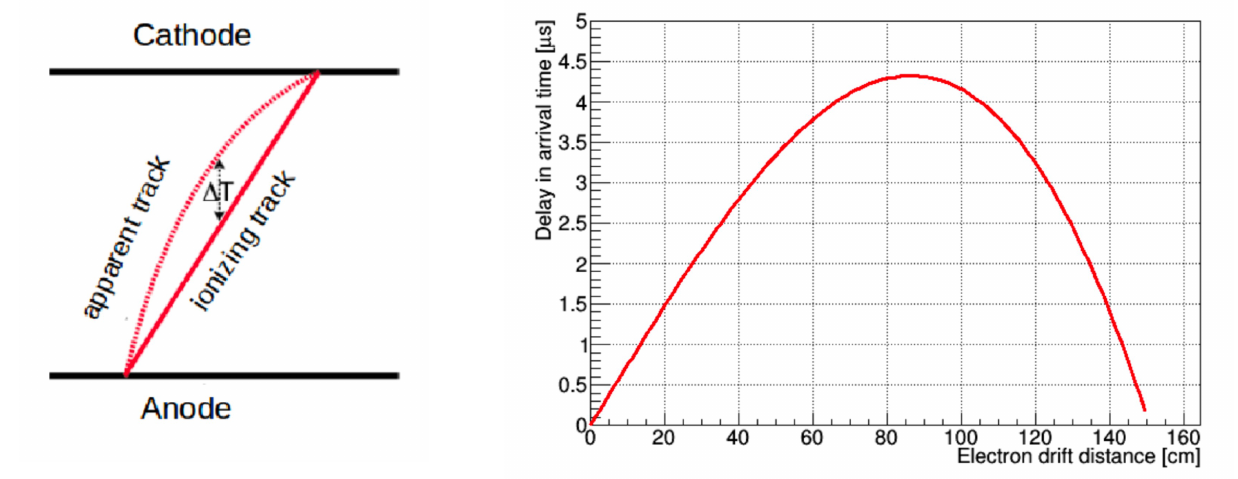
Figure 3. ( Left ): schematic view of the drift time delay δ t . ( Right ): drift time delay dependence on the drift coordinate x . The anode is at x = 0 cm and the cathode at x = 150 cm. Reproduced from reference [13].